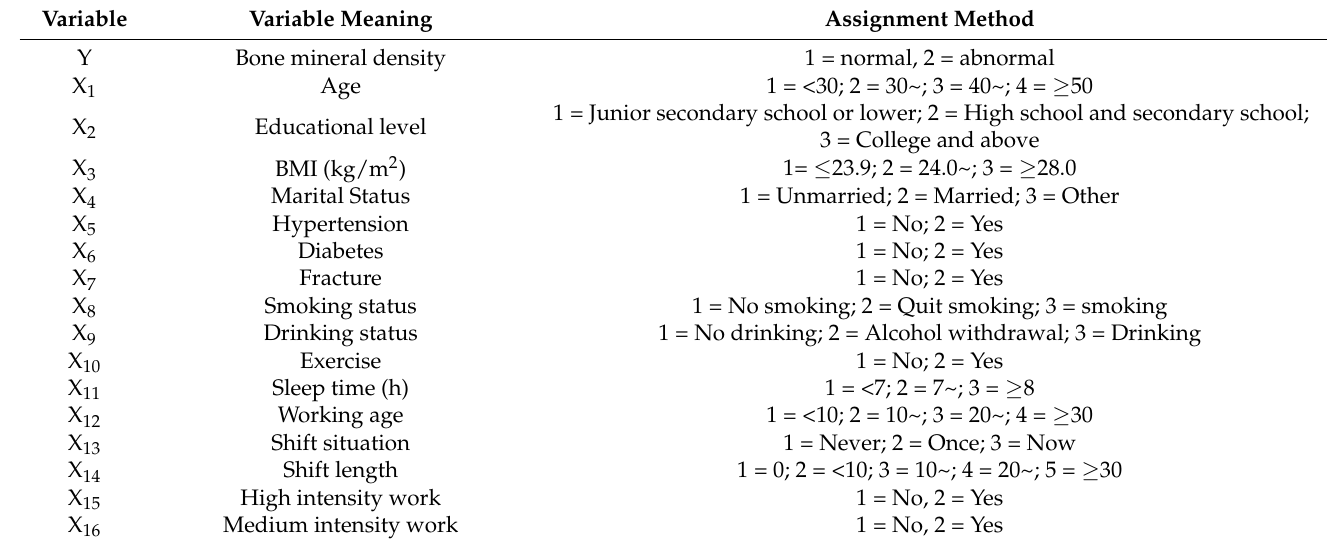
Table 4. Assignment table for variables.